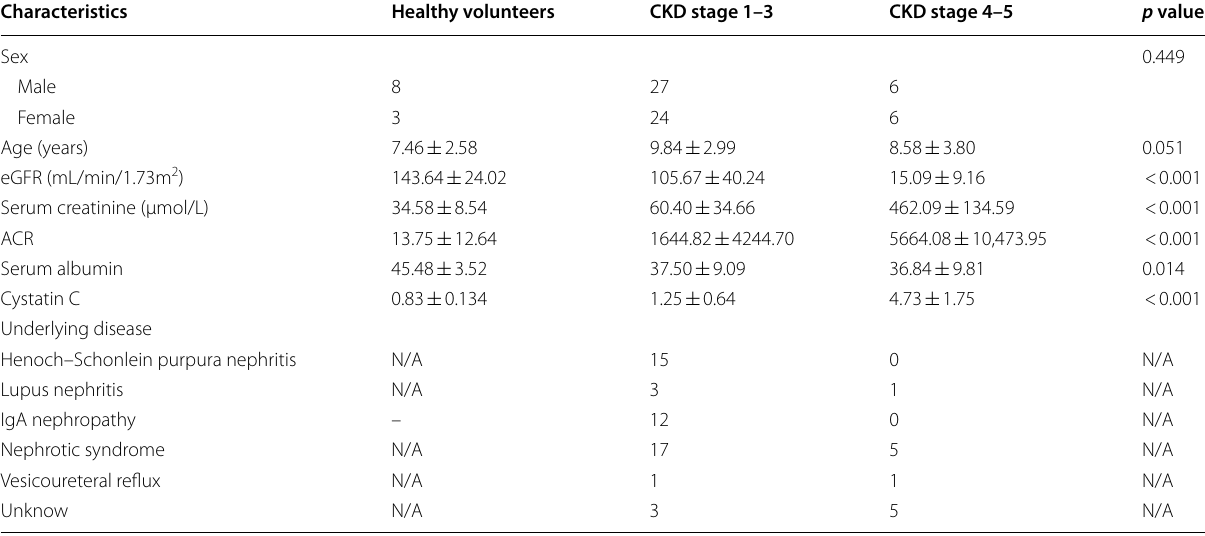
Data are expressed as a number (gender and underlying disease) or means